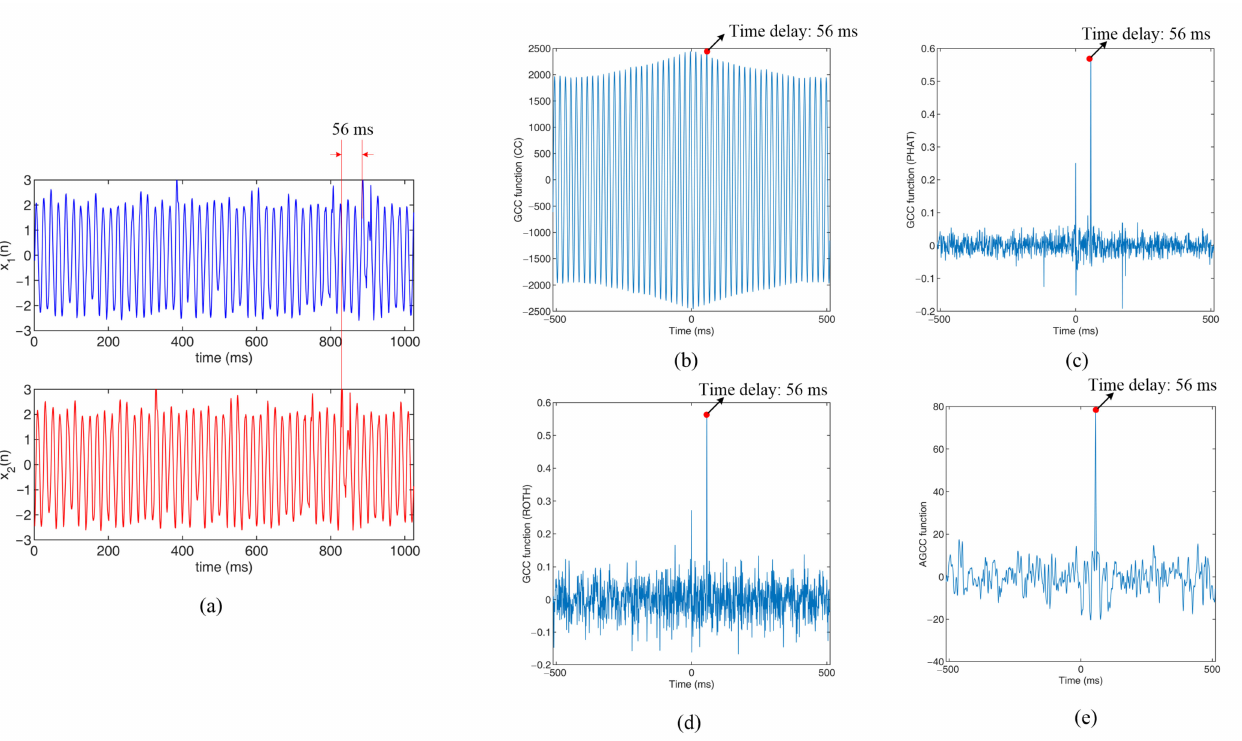
Figure 7. Results of the simulation experiments with A m = 30 and RE = 7.6: ( a ) original signals; ( b ) cross-correlation functions obtained by CC; ( c ) cross-correlation functions obtained by GCC with Roth; ( d ) cross-correlation functions obtained by GCC with PHAT; ( e ) cross-correlation functions obtained by